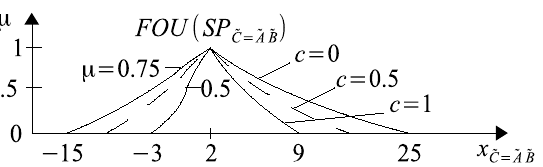
Figure 30. Span function SP ˜ of the 5-dimensional multiplication result of T2FNs ˜ A ˜ B , of which C = ˜ A ˜ B ) shows the inflection line correspond- the number ˜ A contains zero. The left side of the FOU ( SP ˜ C = ˜ A ˜ B = ing to the value x ˜ C